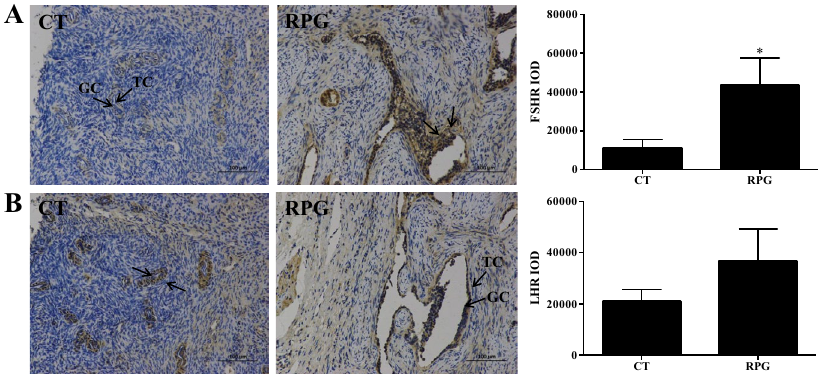
Figure 7. Effects of RPG and CT supplementation on FSHR and LHR expression level in ovarian tissue from postpartum dairy cows. ( A ) Representative micrographs of positive FSHR staining in ovarian tissues. ( B ) Representative micrographs of positive LHR staining in ovarian tissues. The integral optical density (IOD) of FSHR and LHR was calculated by Image-Pro Plus 6.0. B. IC interstitial cell, TC theca cell, GC granulosa cell. Data are presented as the means ± SEM. Compared to the control diet: * P < 0.05.